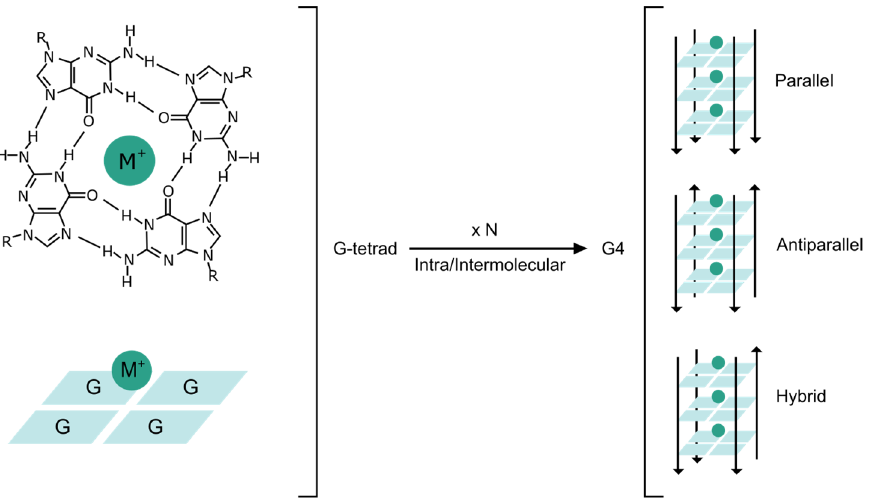
Figure 1. Structure of G4s. Chemical structure of a guanine (G) tetrad, which is stabilized by Hoogsteen basepairing and a central cation (M + ). A G ‐ tetrad is schematically represented. The self ‐ stacking of several (N) G ‐ tetrads renders different G4 conformations depending on the number and direction of the strands.